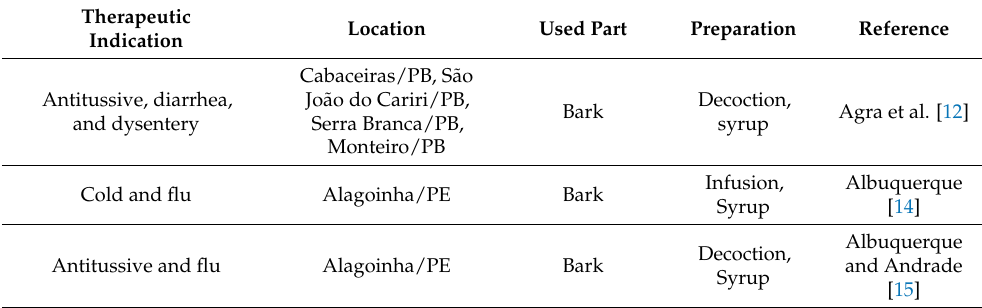
Table 1. List of therapeutic indications of Schinopsis brasiliensis Engler according to the results of the ethnobotanical